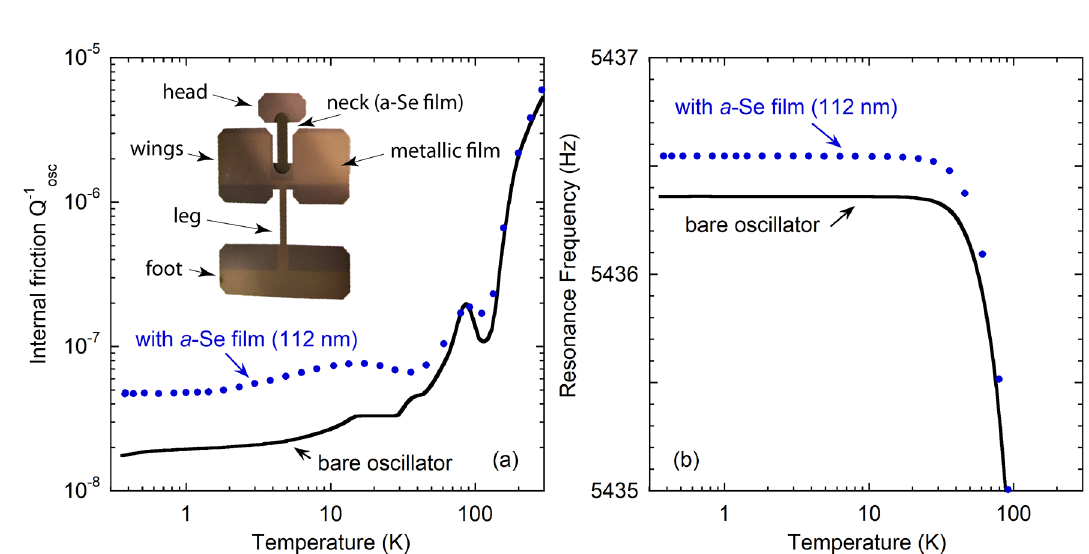
Figure 1. The internal friction, Q osc 1- , (a) and resonance frequency, f , (b) of a DPO before and after thermal evaporation of a 112 nm thick a -Se film. The inset in (a) shows the image of a DPO carrying an a -Se thin films in the neck area where most of the shear strain is concentrated. The light-colored area is coated with a metal